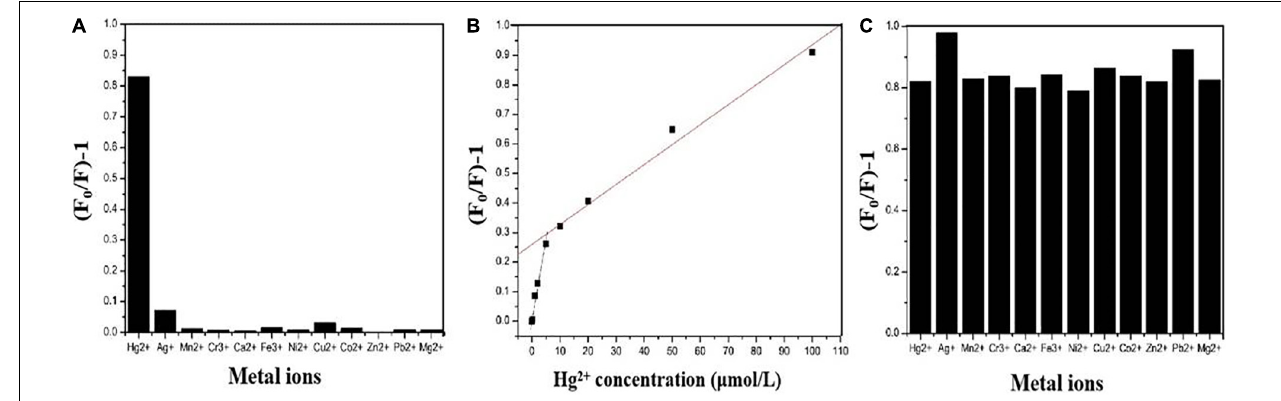
FIGURE 6 | Fluorescent response of CDs-4a in the presence of 10 µ M of different metal ions (A) . Plots of the values of (F 0 /F)-1 versus the concentration of Hg 2 + (B) . Fluorescence response of CDs-4a in the presence of 10 µ M Hg 2 + and 10 µ M another kind of metal ions (C) .